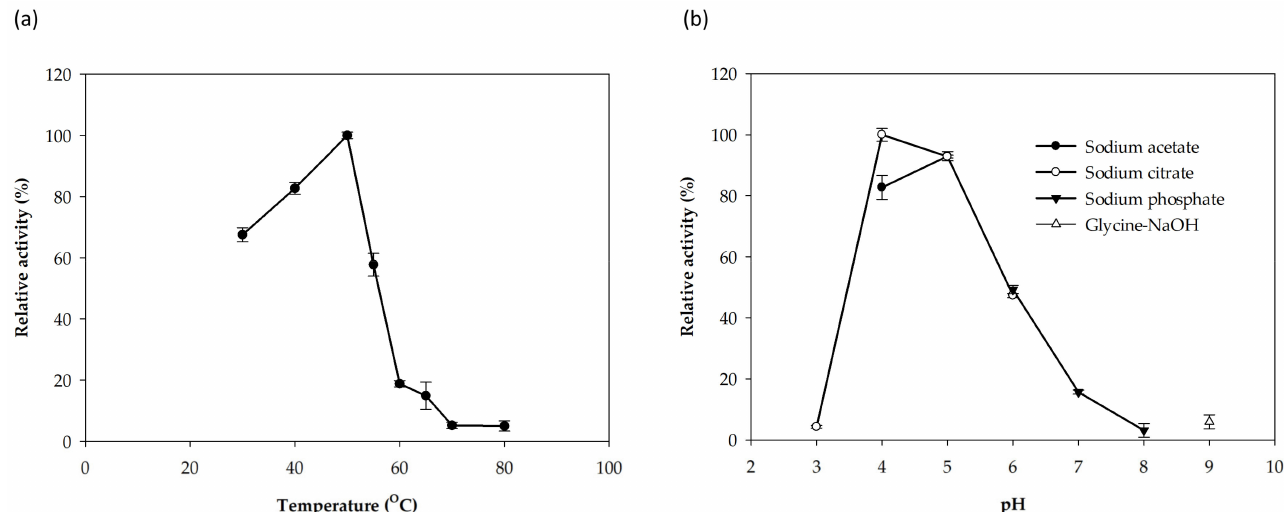
Figure 5. The effect of temperature and pH on amylase activity. ( a ) The effect of temperature on amylase activity was determined at temperatures ranging 30–80 ◦ C ( b ) The effect of pH was measured in various buffers ranging pH